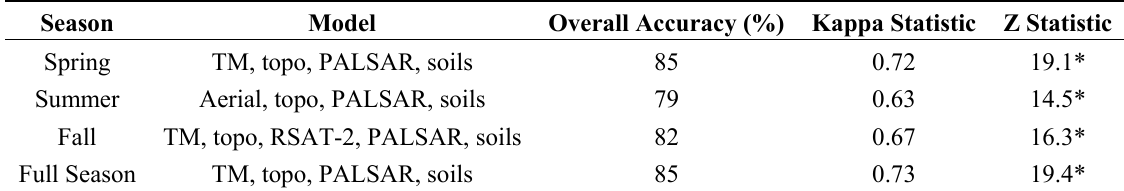
Table 8. Summary of results for the best seasonal random forest models for the Level 1 land cover classification.